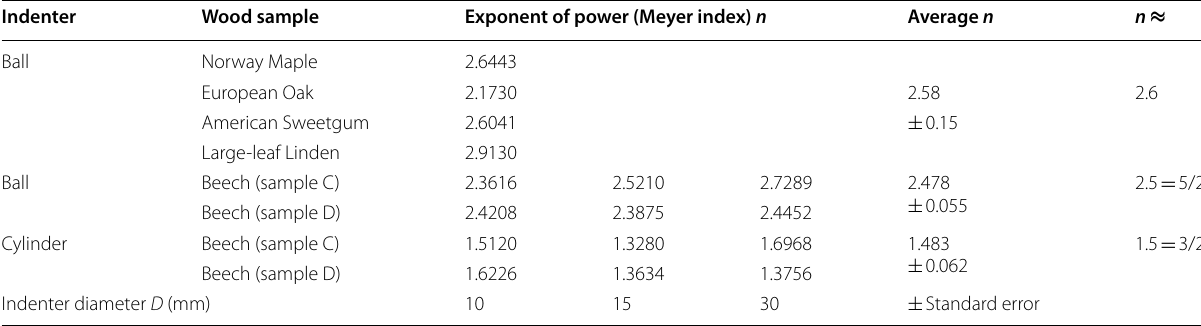
Table 1 Experimental values of exponents in Meyer law for balls and cylinders